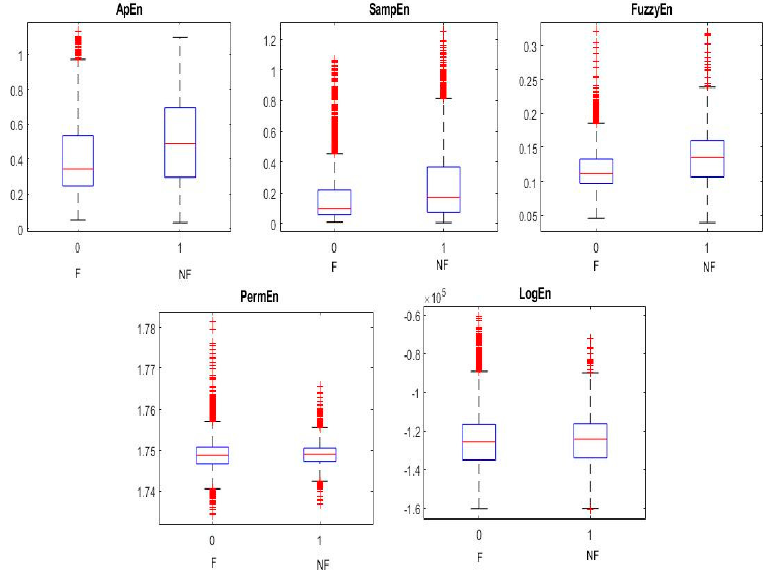
Figure 8. The box plots of the NFC and FC classes in the Bern-Barcelona dataset.